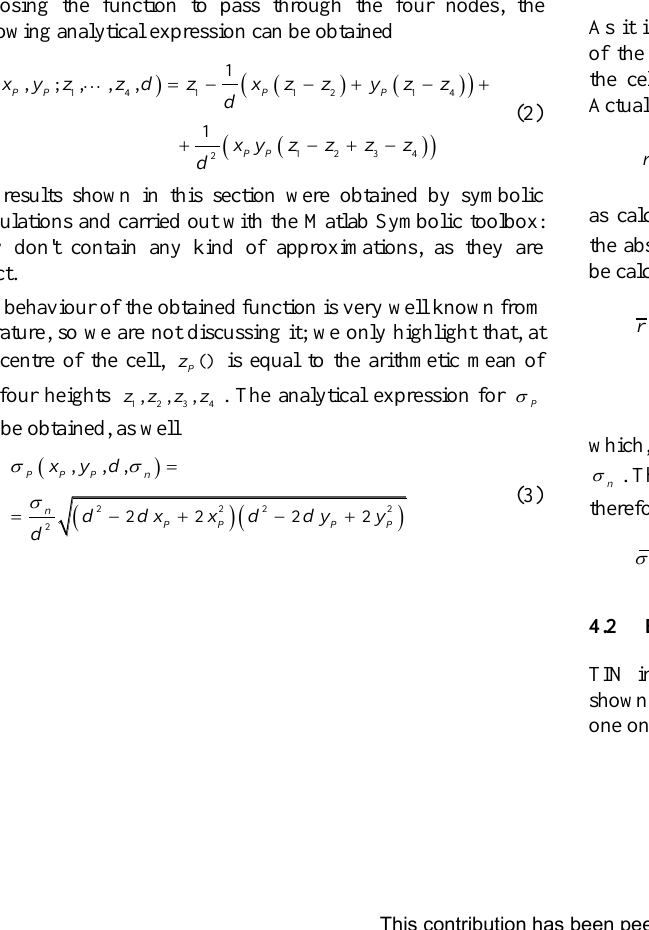
Figure 2 . Plot of the ratio x y ;   as a function of   , P n P P cell size was set to 10 in order to produce the plot, but the function's shape is independent from d .